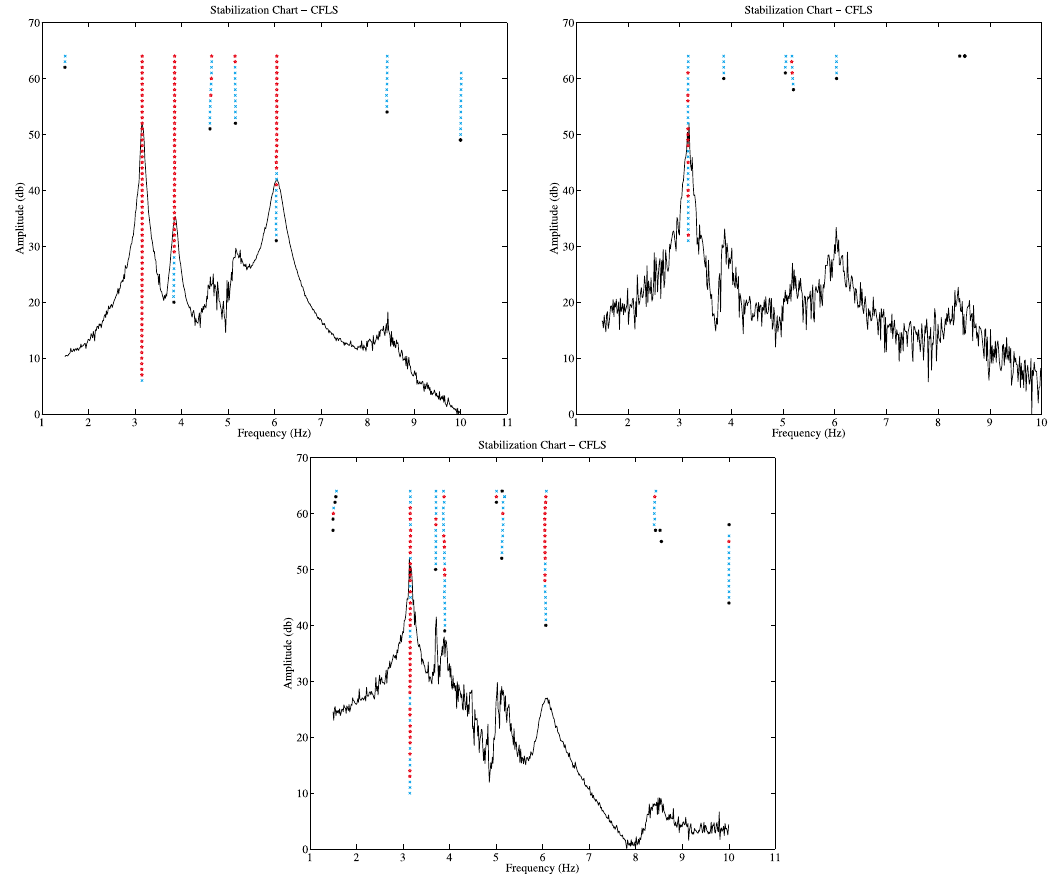
Fig. 5. Stabilization diagrams based on (top left) FRFs (top right) power spectra based OMA (bottom) Transmissibility based